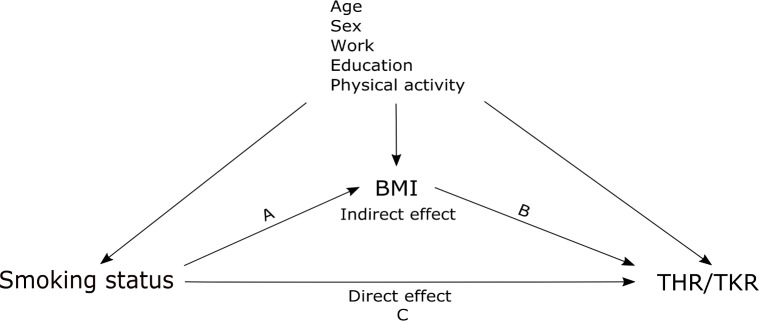
Model of the potential mediating effect of body mass index (BMI) on the relationship between smoking status and hip or knee replacement (THR/TKR).The total effect of smoking includes the product of the direct (C) and indirect (AB) effects.